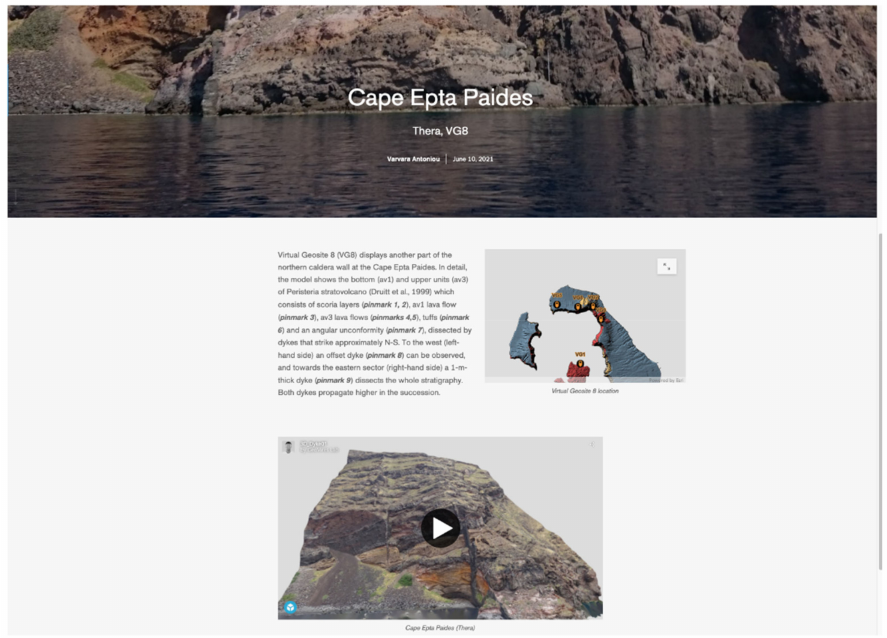
Figure 5. Representative screenshot of the StoryMap that corresponds to the Cape Epta Paides virtual geosite. Users can return to the main page by using the “Virtual Geosites” button in the upper-left